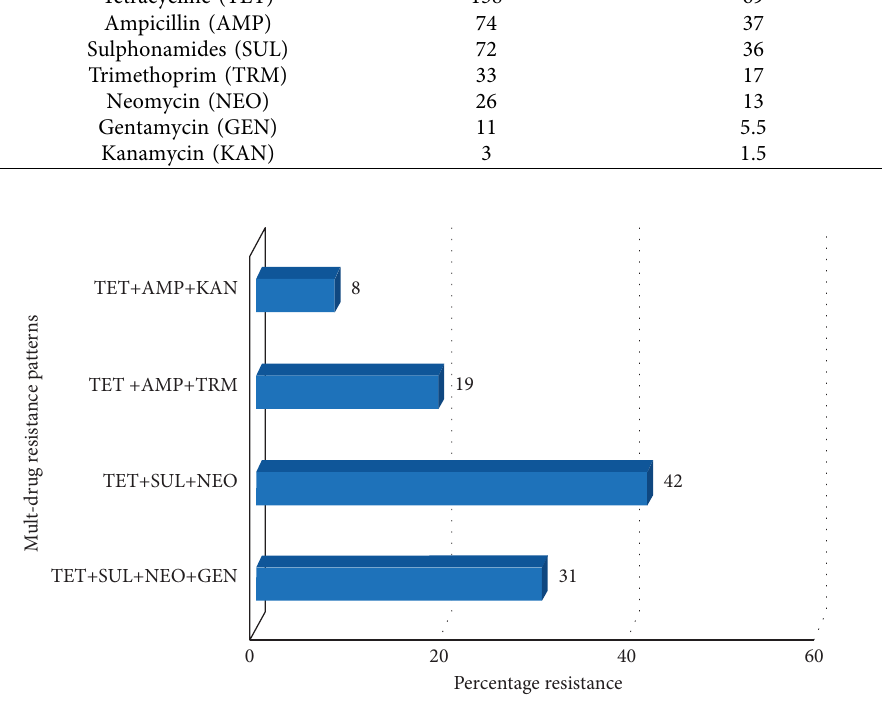
Figure 3: MDR patterns of E. coli from poultry in Masindi